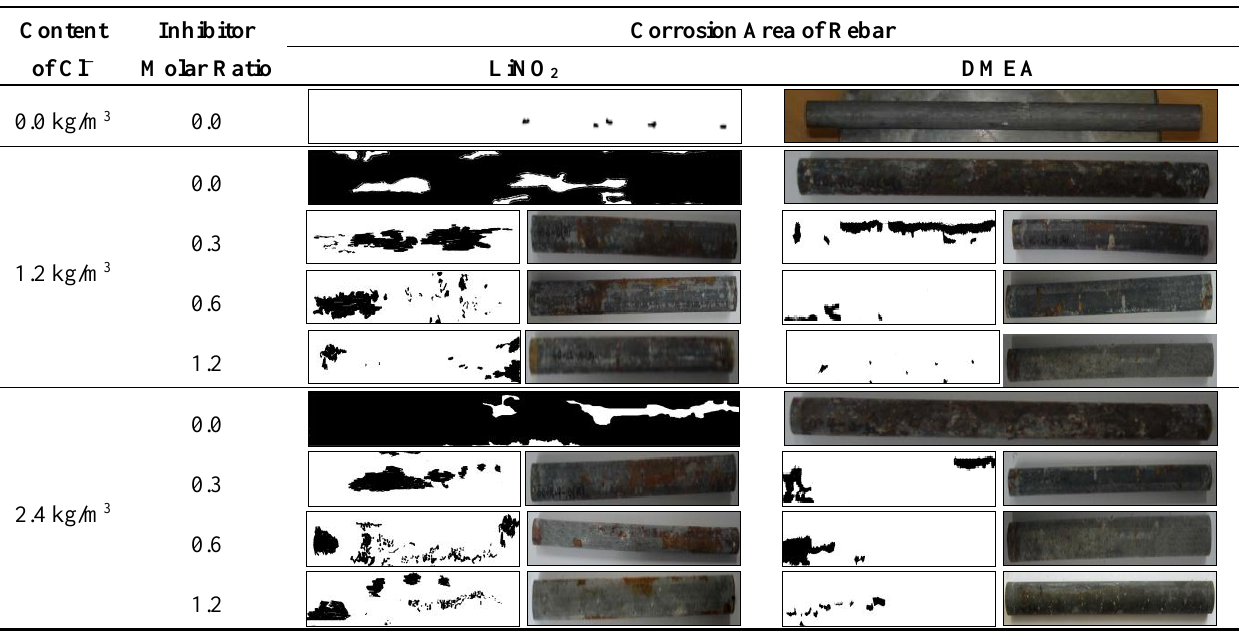
Figure 10. Appearance of reinforcing steel corrosion at the chloride ion concentration of 2.4 kg/m 3 and inhibitor molar ratio of 1.2. ( a ) Lithium nitrite inhibitor (LiNO 2 ); ( b ) Amino-alcohol inhibitor (DMEA). Table 9. Corrosion states of the reinforcing steel after accelerated